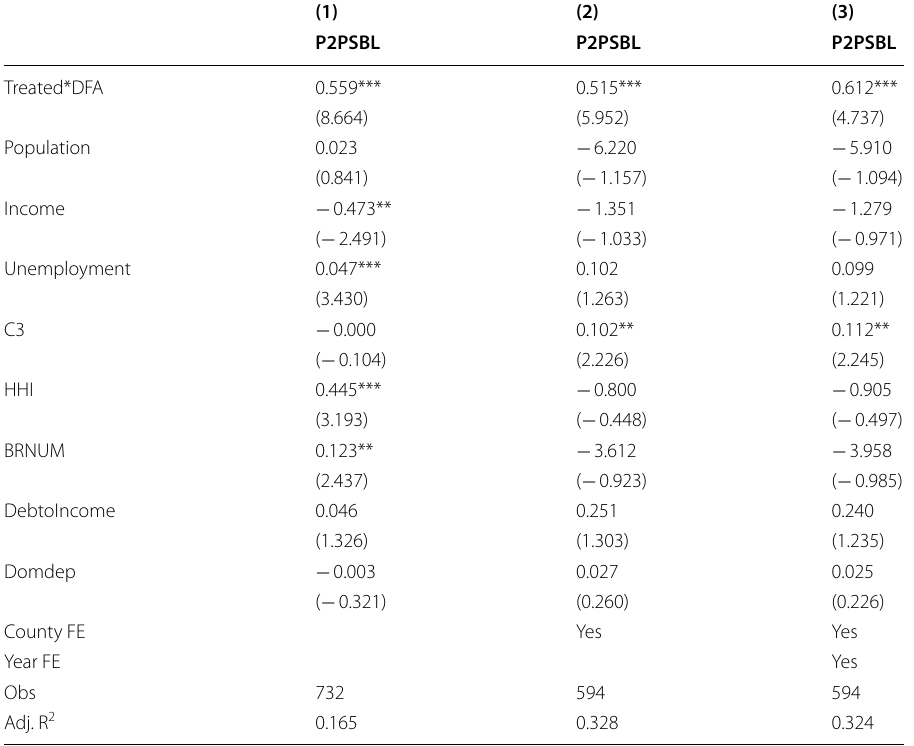
Table 10 Robustness results for alternative P2P